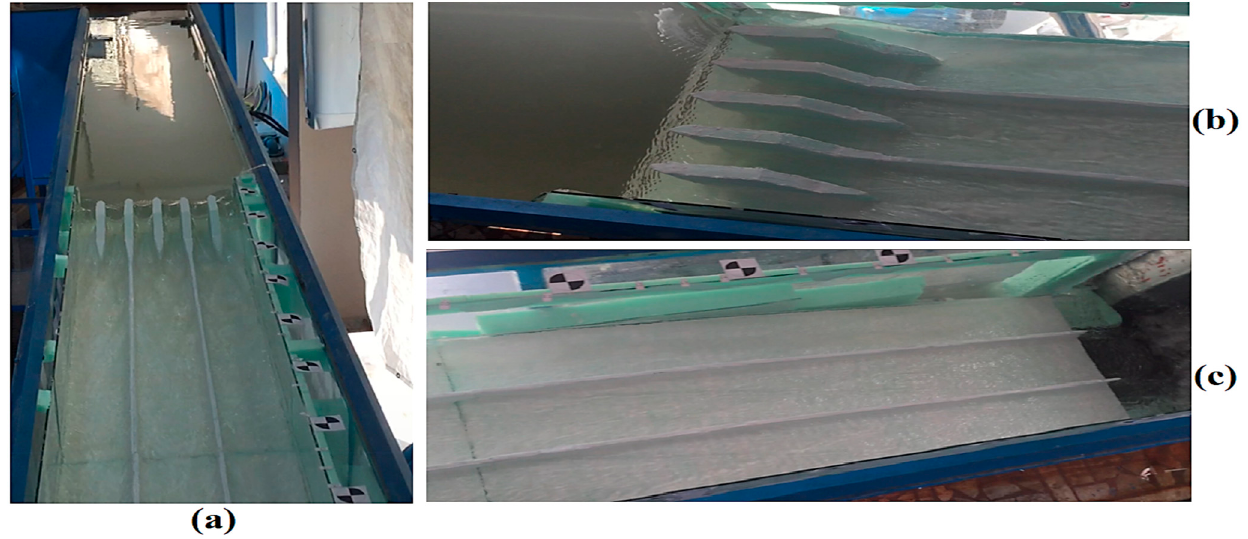
Figure 4. Model image of the spillway in the experiment: ( a ) top view; ( b ) flow inlet part; ( c ) flow output part.